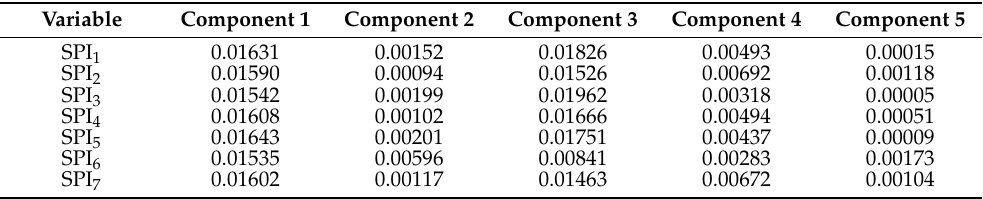
Table 7. Social development indicator contributions by the main